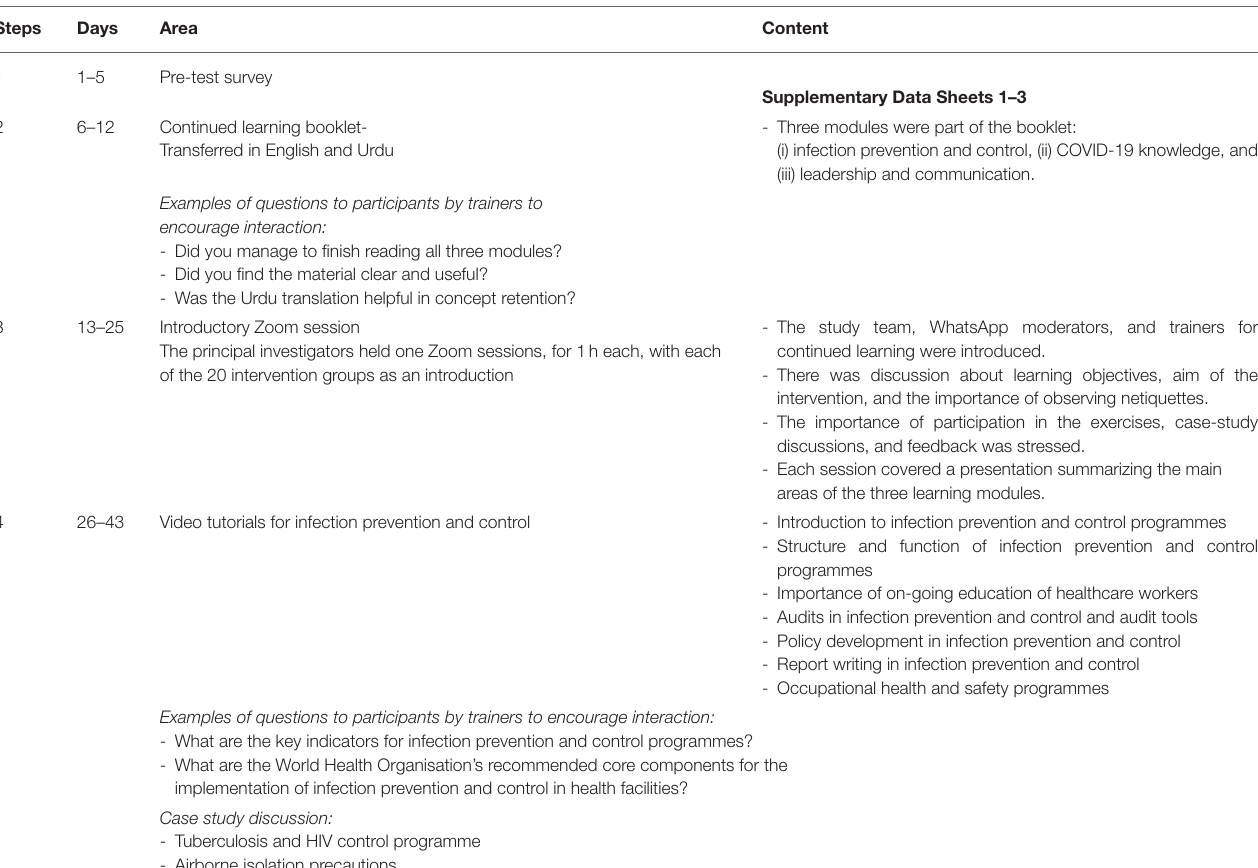
TABLE 1 | Literacy modules instruction plan for intervention